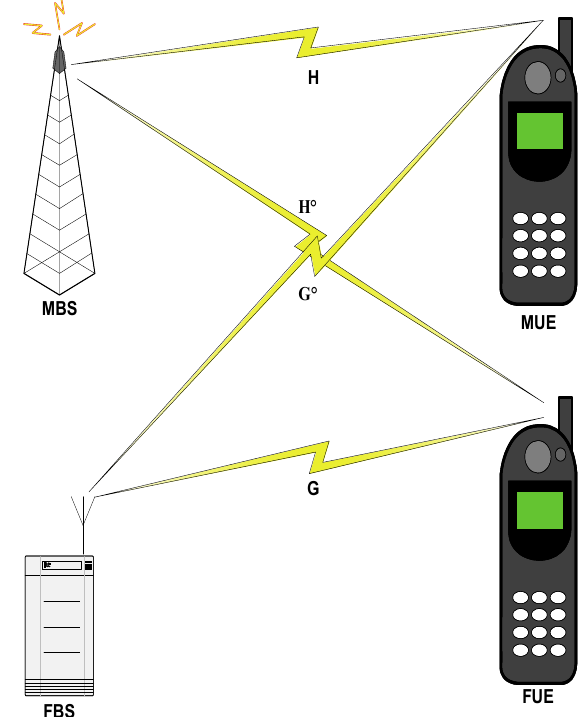
Fig. 4. Downlink TX channel model in a 5G network. The process of RF channel resource allocation to MUEs and FUEs from the centralised MBSs and FBSs is illustrated in a block diagram shown in Figure 5. The RF channel resources are allocated to the MUEs and FUEs based on their current SINR levels from the centralised MBSs and FBSs.